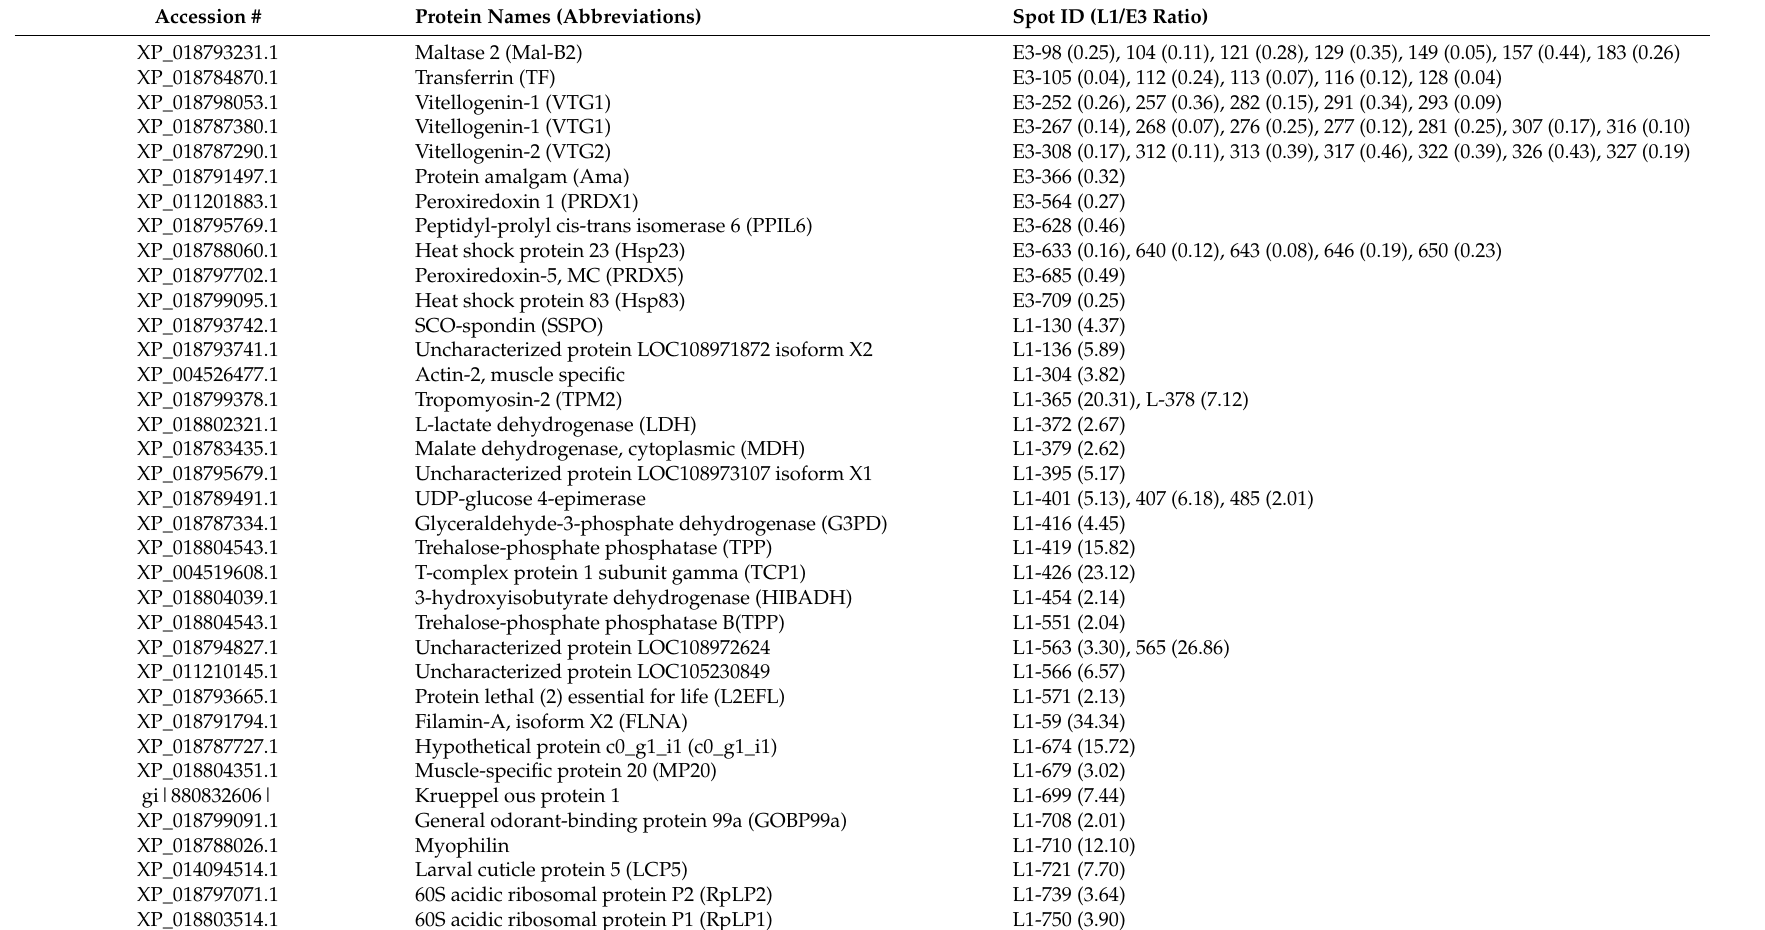
Table 1. Differentially expressed proteins between 3-day-old eggs and 1-day-old larvae of B.